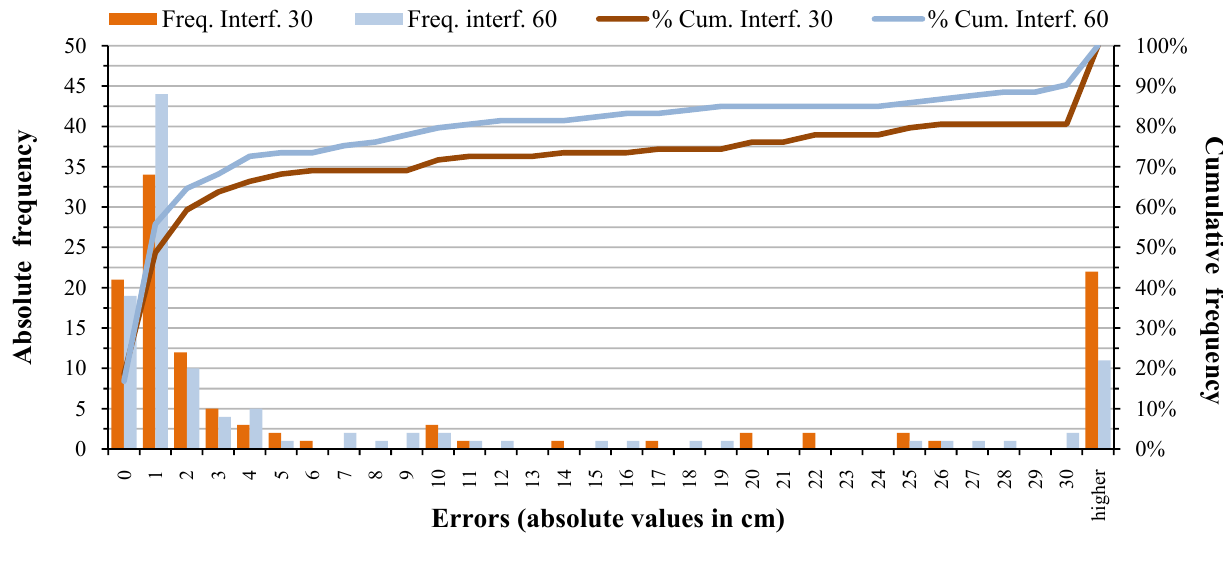
Figure 12. Histogram and cumulative frequencies of errors caused by interferences from adjacent sensors at ±30 cm and at ±60 cm for the field interference